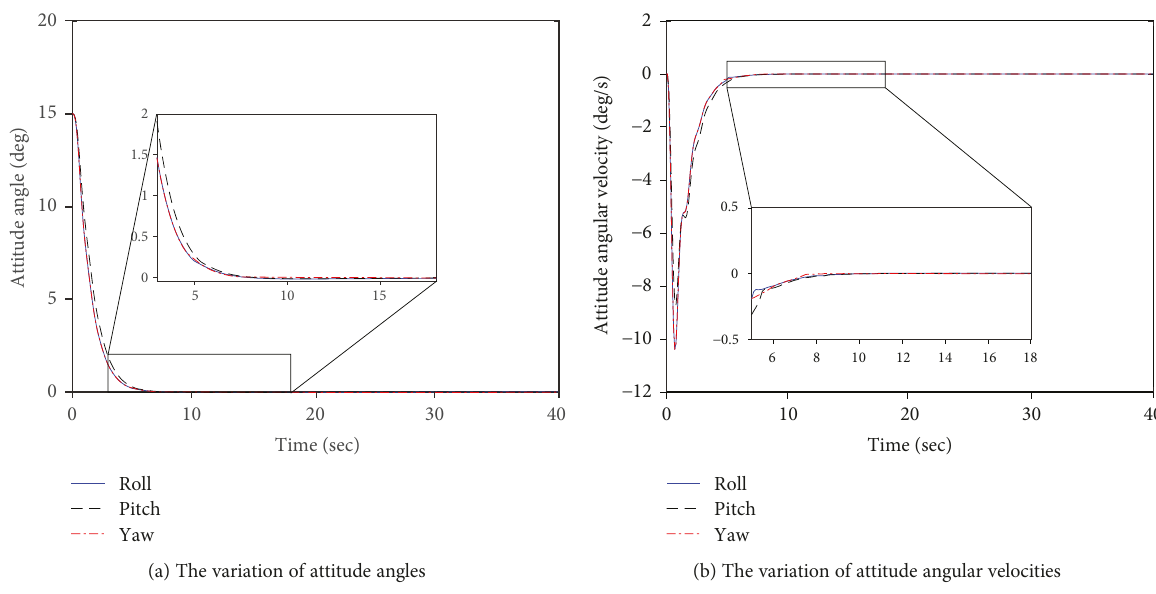
Figure 17: Control results of SPMA using